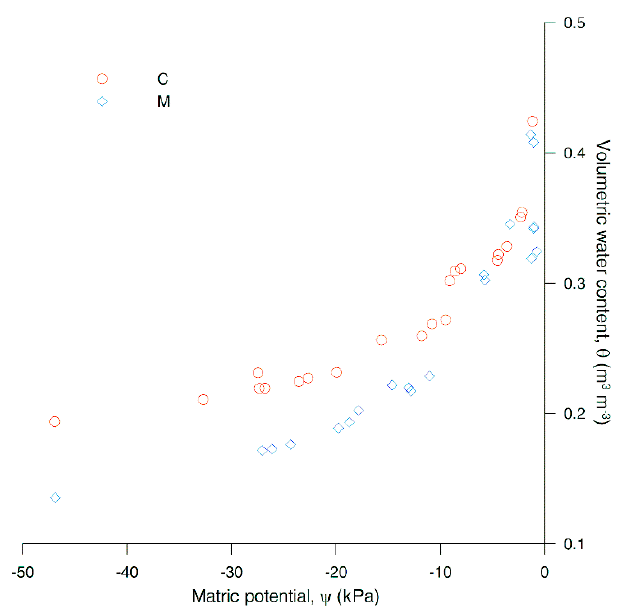
Figure 9. Water retention curves, θ ( ψ ), measured by the QSC method for lithotypes C and M.